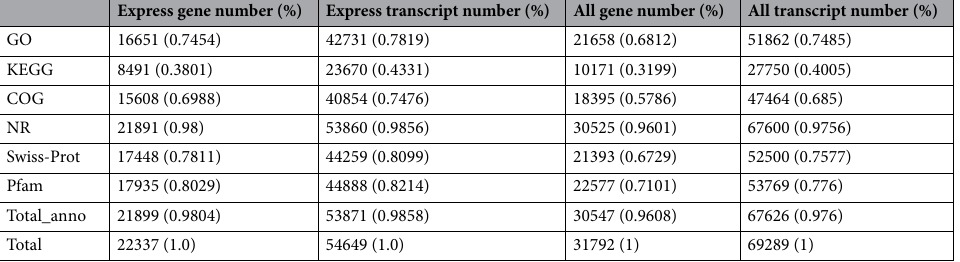
Table 2. Success rates of gene annotation in different databases.